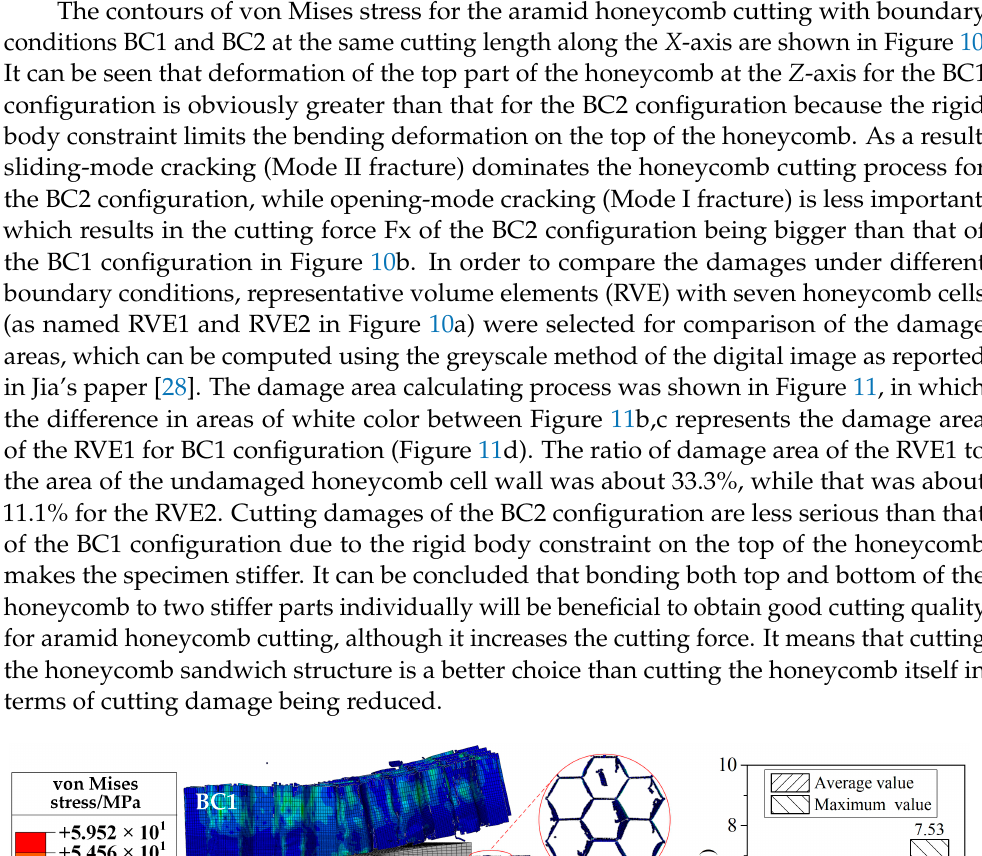
Figure 9. Illustration of boundary conditions for the honeycomb: ( a ) BC1; ( b ) BC2.